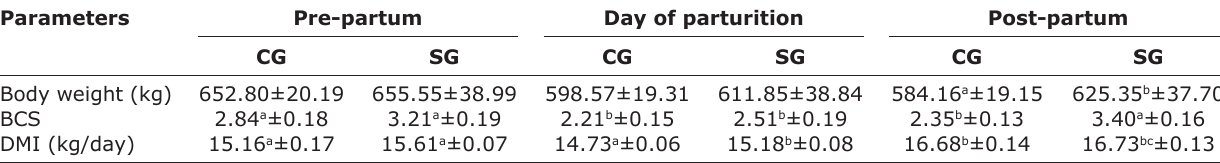
Table-4: Mean body weight, BCS and DMI during different periods of experiment in buffaloes. Parameters